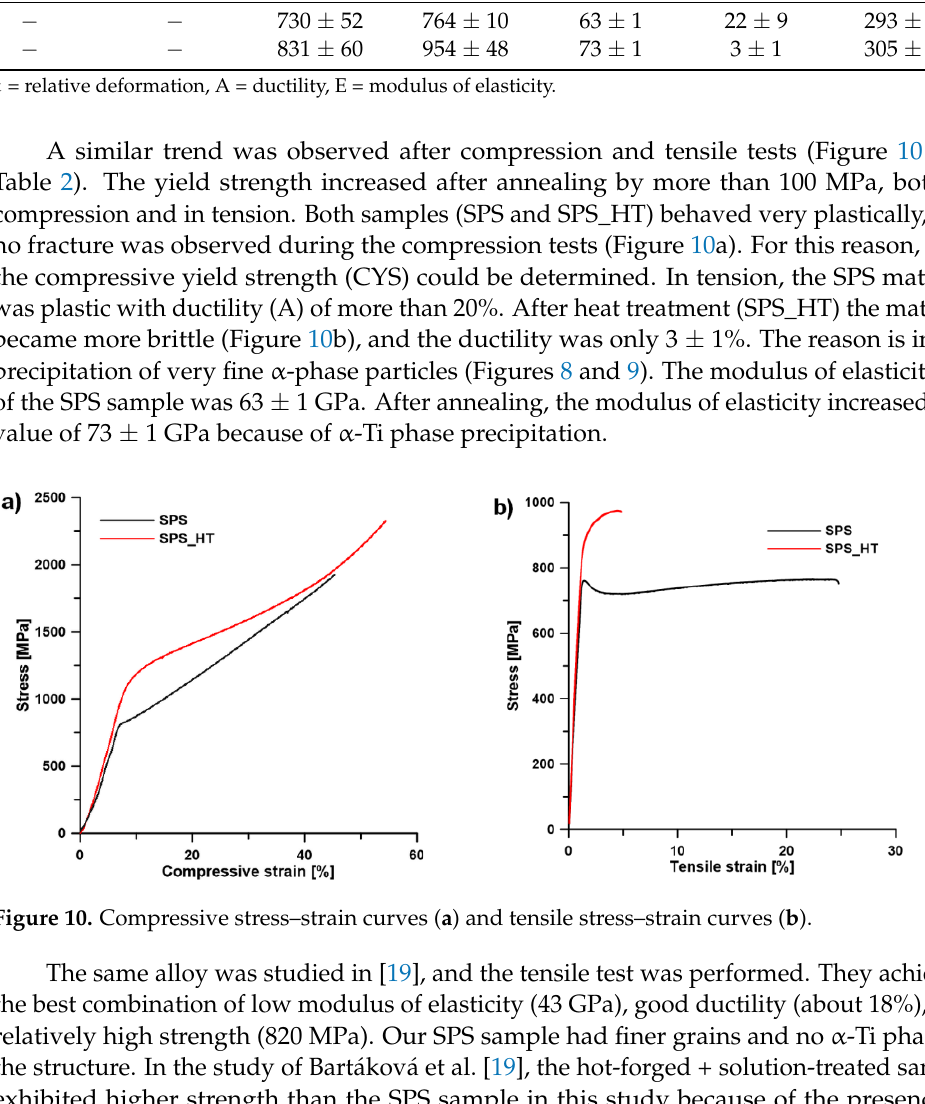
Table 3. Comparison of mechanical properties of selected alloys in tension.